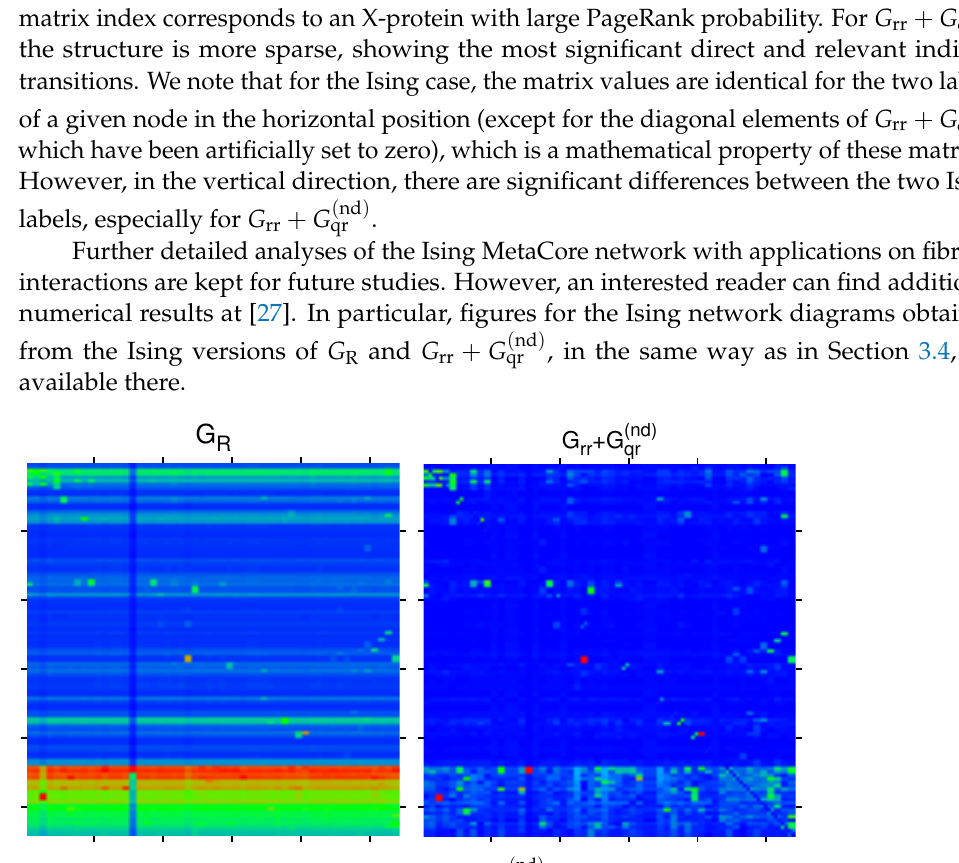
( nd ) Figure 8. Color density plots of G R and G rr + G qr for the bifunctional Ising MetaCore network and the extended group of 108 nodes by attribution of labels (+) and ( − ) to each node of Table 1. The matrix plot style is similar to in Figure 2, with outside tics indicating multiples of 20 of the index values. The color bar is as in Figure 2 with the same translation of colors to matrix values. The saturation value is, for both panels, the sixth largest value for each matrix, and larger values are reduced to this value. The strongest cell values are reduced from 0.437575 (0.424939) to 0.101874 ( nd ) (0.060717) for G R ( G rr + G qr